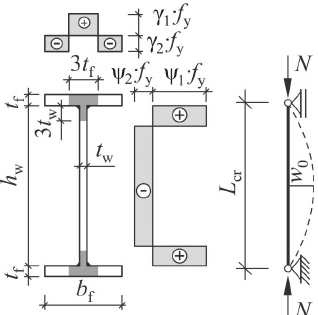
Fig. 16. Geometry and imperfections of the analysed column